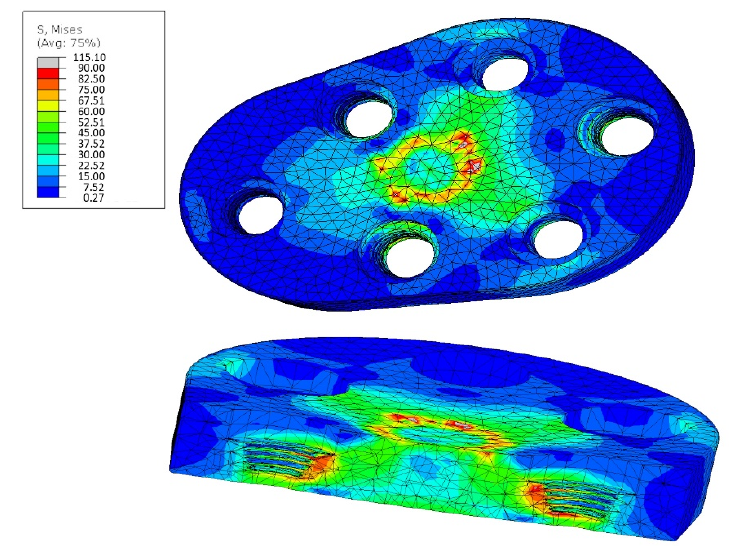
Figure 8. FEM Analysis of the rigid variant: strain at 1500 N, scaling 90 MPa.